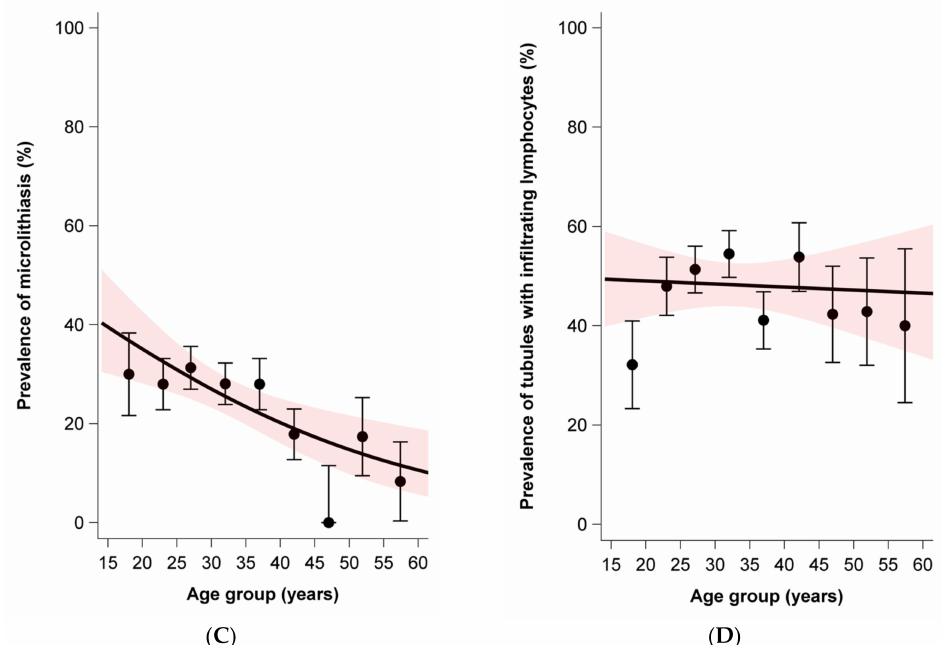
Figure 2. Age dependence of lymphocytic infiltration, germ cell neoplasia in situ (GCNIS), testicular microlithiasis, and tubules with infiltrating lymphocytes among sporadic and familial testicular germ cell tumors. Dots and whiskers indicate the age group specific prevalence +/ − 1 standard error; the red bands display the 95% confidence interval (95% CI) bands; all models include age only; odds ratios (OR) per 5-year age increase. ( A ) Prevalence of lymphocytic infiltration by age at diagnosis. OR = 1.21 (95% CI: 1.11–1.33). ( B ) Prevalence of GCNIS by age at diagnosis. OR = 0.78